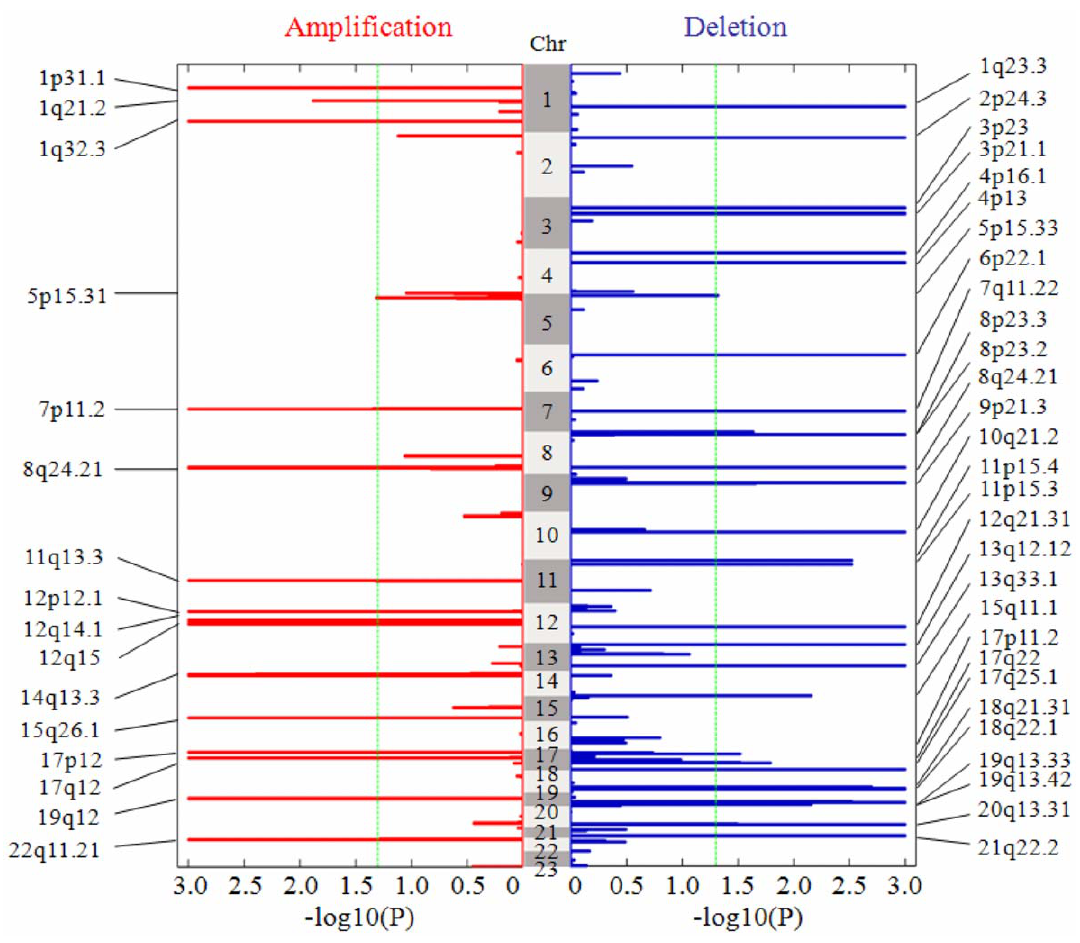
Figure 4. The landscape of statistical significance levels of the genome in the 371 lung adenocarcinoma subjects. 2 log10 (p-values) are given for amplification and deletion regions respectively. The dashed green line is placed at 1.3 (corresponding p-value of 0.05) as a cutoff for calling significant consensus events. Chromosome 23 indicates the sex chromosome.